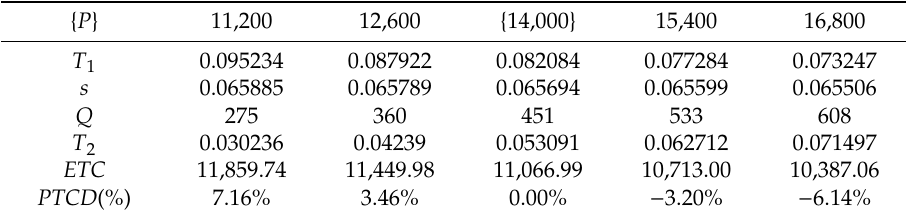
Table 9. Sensitivity analysis when the production rate changes.